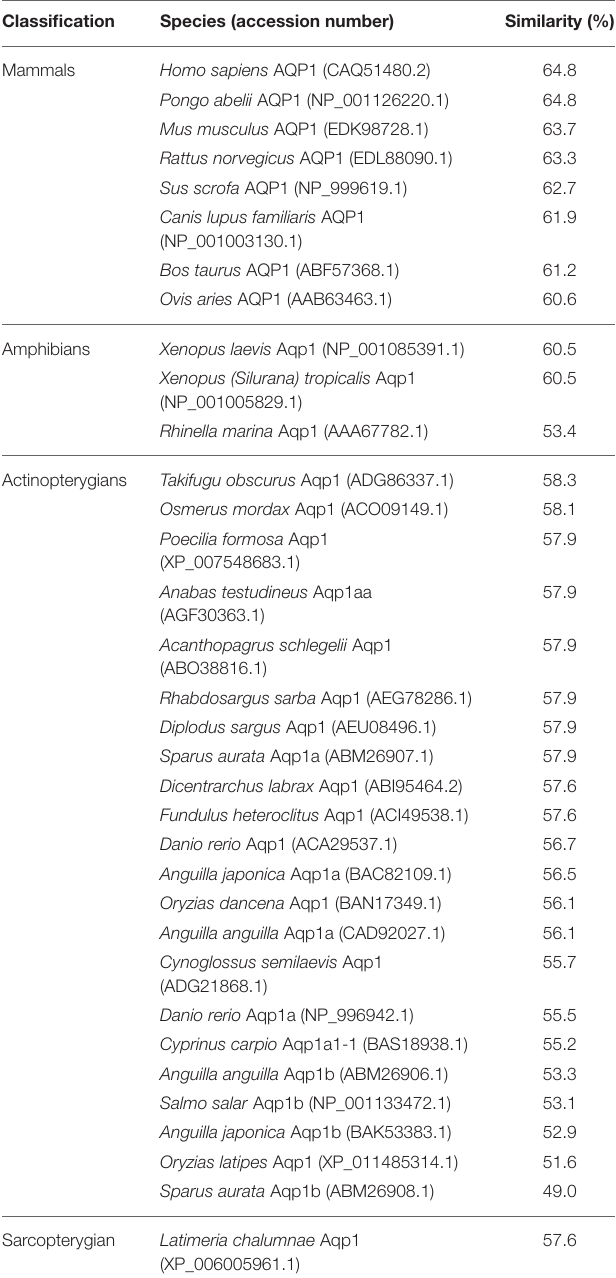
TABLE 2 | The percentage similarity, arranged in a descending order, between the deduced amino acid sequence of aquaporin 1 (Aqp1) from Protopterus annectens and Aqp1/AQP1 sequences from other animal species obtained from GenBank.